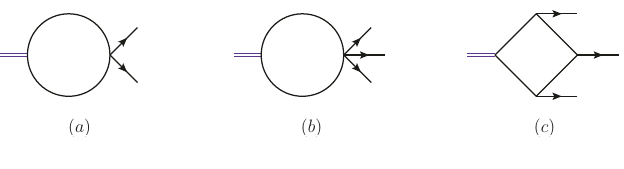
Figure 1 . The one-loop masters.